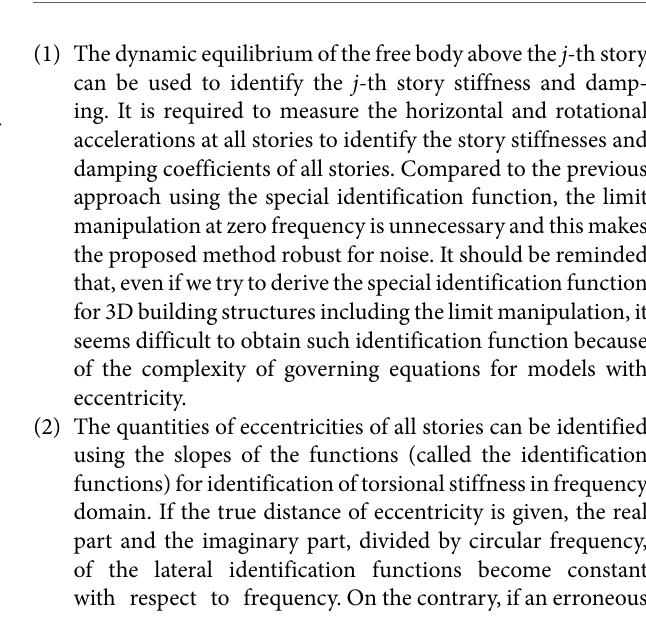
were employed as the input ground motions. The sampling time increment is 0.01 s.